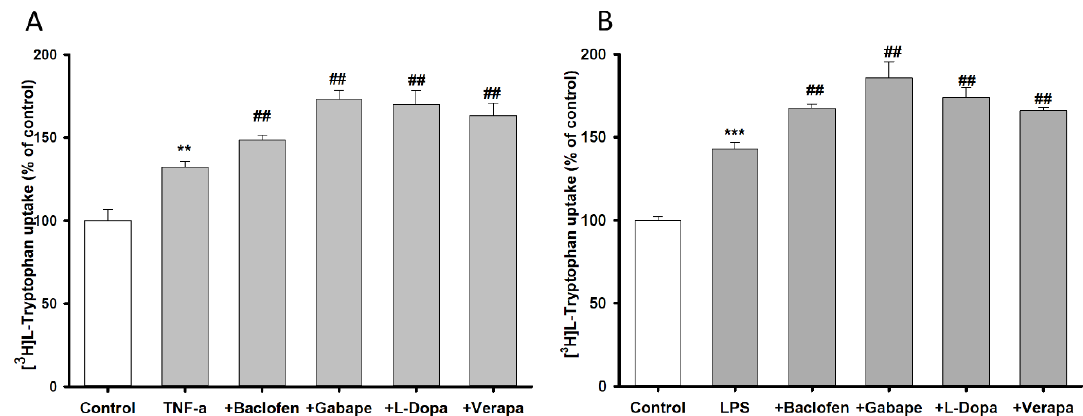
Figure 4. Pretreatment effect of inflammatory stimuli on [ 3 H] L -tryptophan uptake by TR-BBB cell lines at 37 °C for 5 min. ( A ) TNF- α and ( B ) LPS were used at a concentration of 20 ng/mL, followed by treatments with baclofen (2 mM), gabapentin (0.5 mM), L -dopa (0.1 mM), and verapamil (0.1 mM). Data are presented the mean ± SEM ( n = 4). *** p < 0.001, ** p < 0.01 indicates a significant difference from the control, ## p < 0.01 indicates a significant difference from the respective control (TNF-α or LPS).